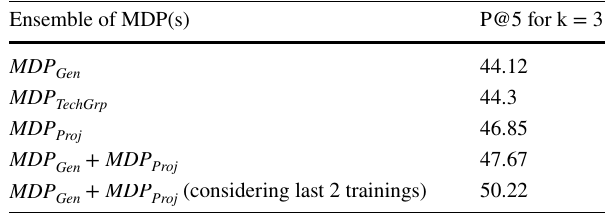
Table 8 Comparison of various ensemble of fMDPs for predicting next